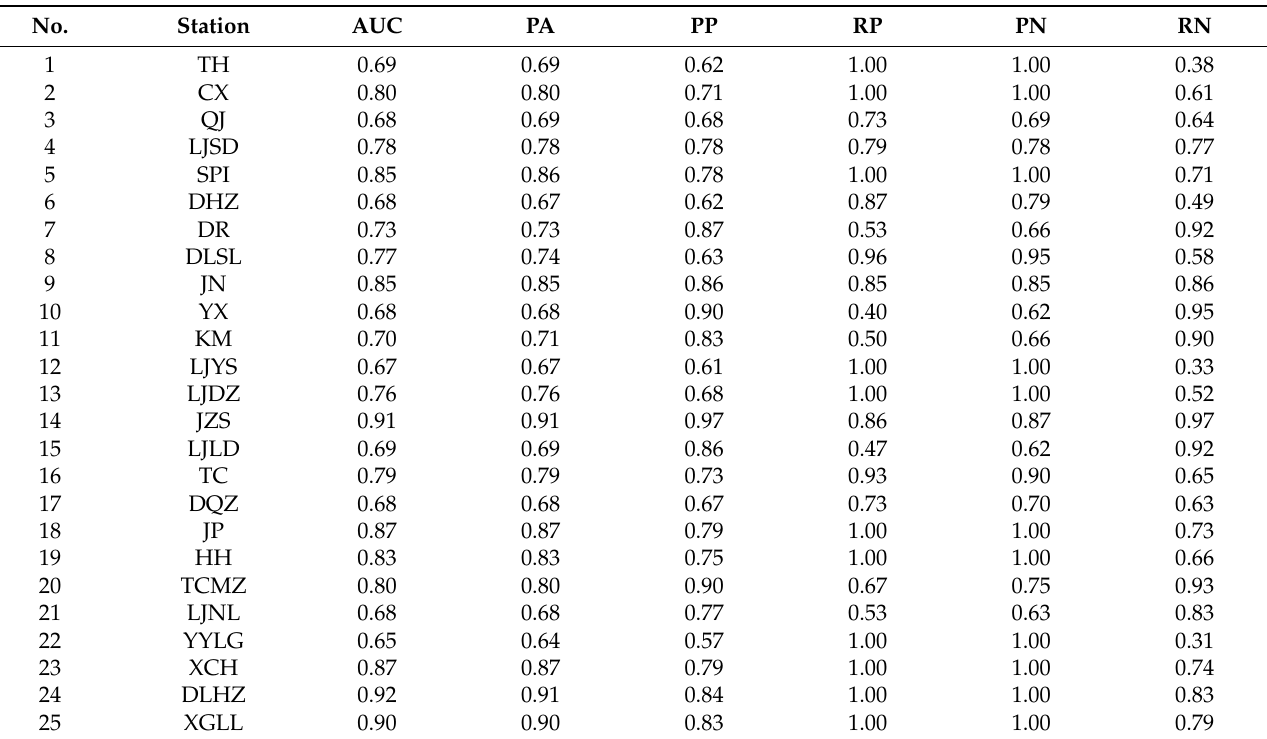
Table A4. Prediction results of LSTM on area3.